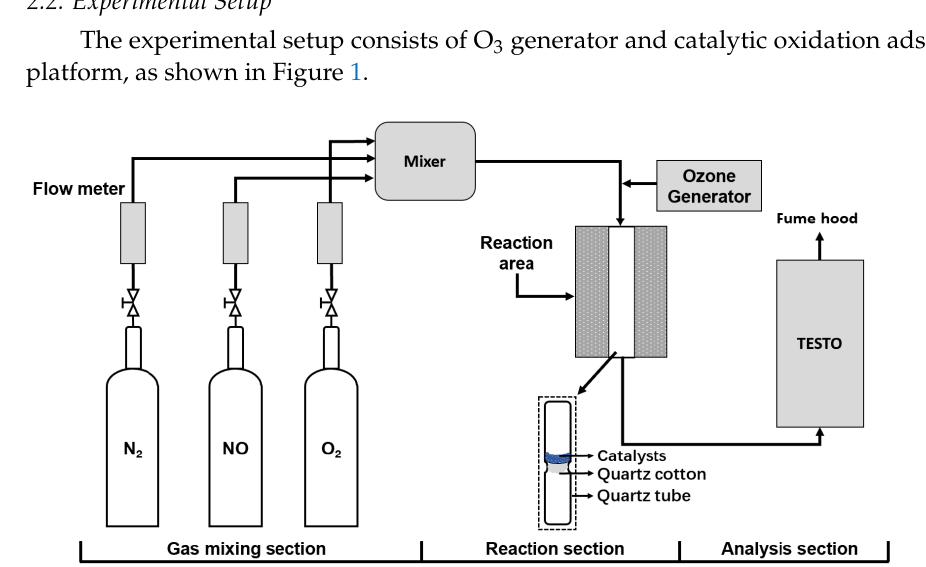
Figure 1. Experimental setup and flow chart.